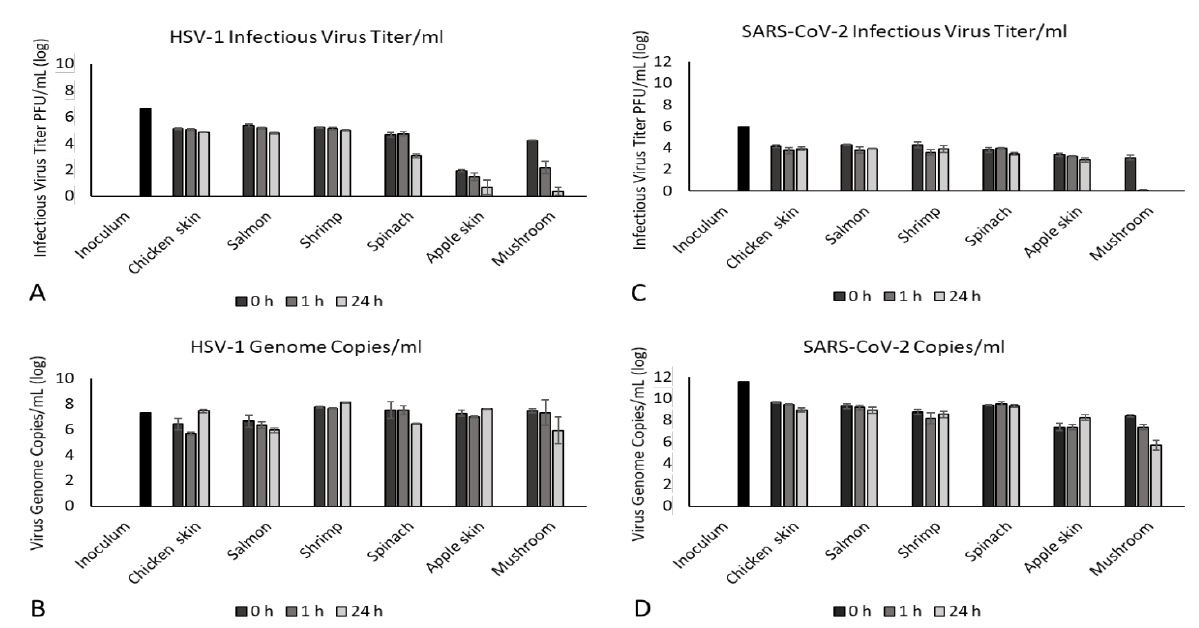
Figure 4. Comparison of infectious virus titer and viral genome copy number. Infectious viral titers were determined by plaque assay for ( A ) HSV-1 on Vero 76 cells, and ( C ) SARS-CoV-2 on Vero E6 cells, shown as log PFU/mL. Viral genome copies were determined by qPCR/RT-PCR for ( B ) HSV-1 by qPCR using primers and probe specific for the HSV-1 thymidine kinase (TK) gene, and ( D ) SARS-CoV-2 by RT-qPCR using primers and probe specific for the SARS-CoV-2 nucleocapsid (N) gene, shown as viral genome copies/mL.